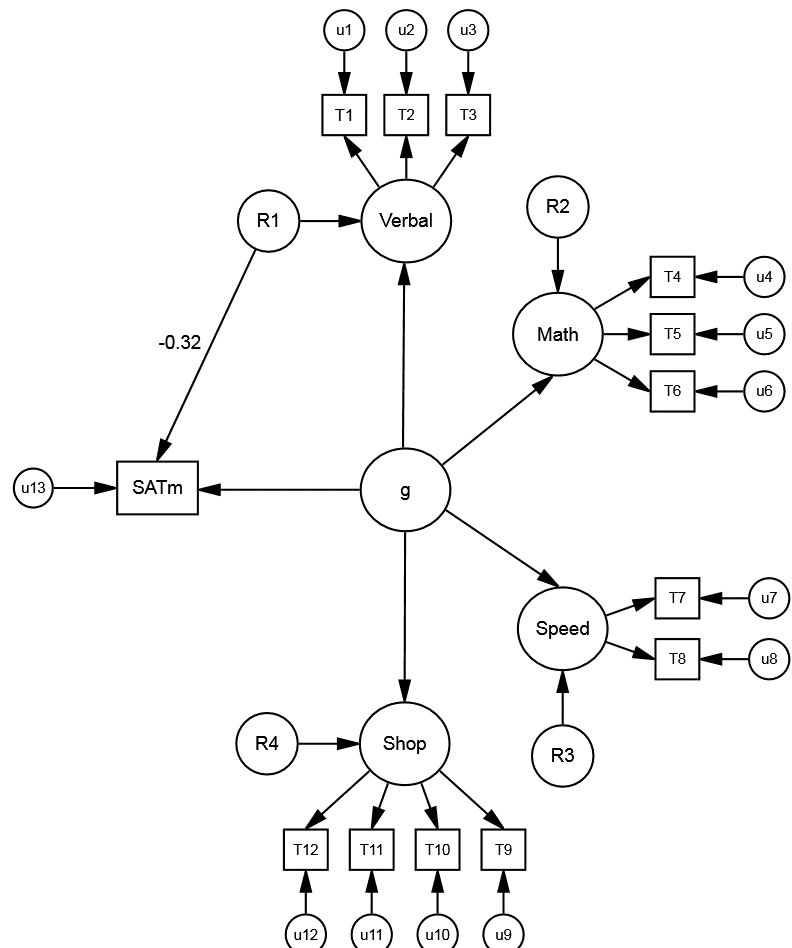
Figure 4 . Model of g with ASVAB abilities (math, verbal, speed, shop). The symbol “R1” represents the ASVAB verbal non- g residuals, obtained after removing g . The R1 → SAT math path estimates the relation of the ASVAB verbal non- g residuals with the SAT math subtest ( β = − 0.32). Figure adapted from Coyle